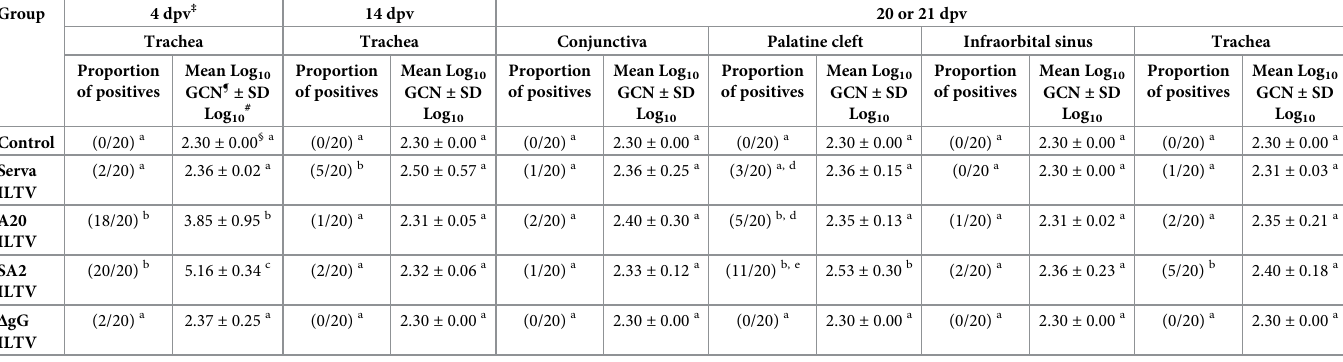
Table 1. Proportion of ILTV positive swabs and genome copy numbers in samples collected from SPF chickens after eye-drop vaccination with Serva, A20, SA2, Δ gG ILTV, or mock inoculation with sterile